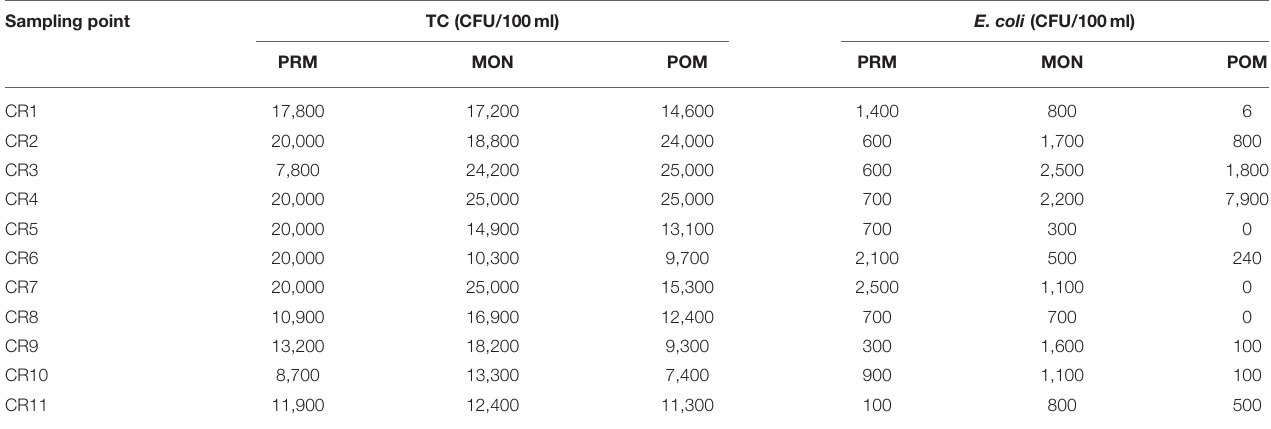
TABLE 2 | Total coliform and E. coli concentration of Churni river in different